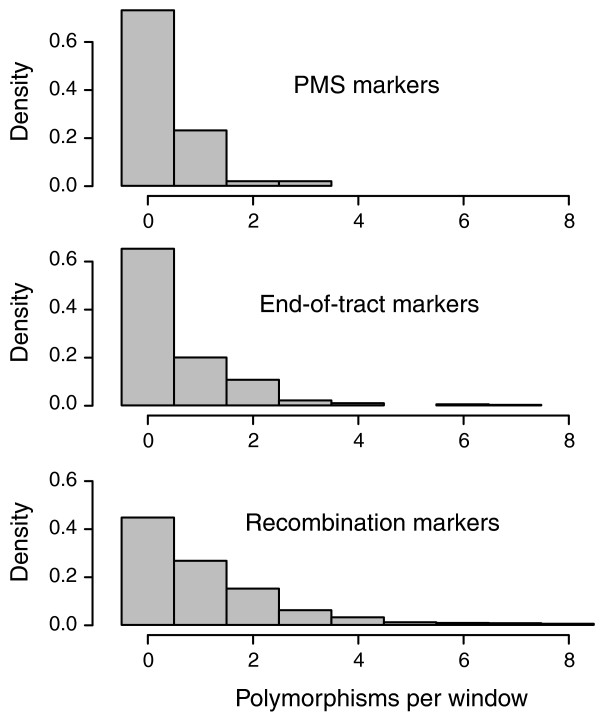
Post-meiotic segregation markers are relatively isolated from other polymorphisms. Histograms showing the marker density in 100-bp windows centered on PMS markers (upper panel), centered on markers located at the end of conversion tracts (middle panel), and centered on overall markers in recombination intervals (lower panel). A range of window sizes produced qualitatively similar results. The median distance to the nearest polymorphism for markers at the end of conversion tracts was 58 bp larger than for all markers in recombination events (Wilcoxon test, P < 0.0001) and the median distance to the nearest polymorphism for PMS markers was 49 bp larger than for all end-of-interval markers (Wilcoxon test, P = 0.002).